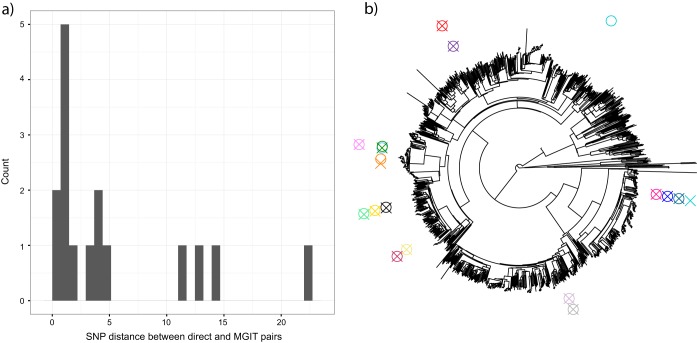
Genotypic concordance between direct and paired MGIT samples. (a) Histogram of genetic (SNP) differences, excluding the one pair that differ by 1,106 SNPs; the median (and modal) difference is 1, and thus, direct sequencing is identifying the same strain of M. tuberculosis that culture-based sequencing would. (b) Placing direct/MGIT pairs on a phylogenetic tree of 3,480 samples shows the distribution of samples across world diversity. A circle indicates the sequence from the direct sample, and an X indicates the sequence from the corresponding MGIT sample. For the 1 pair (of 17) with 1,106 differences (turquoise), the MGIT sample is placed very close to the other samples (zero SNP differences from one [MGIT] sample and five SNP differences from the others) and so is possibly due to a labeling error.